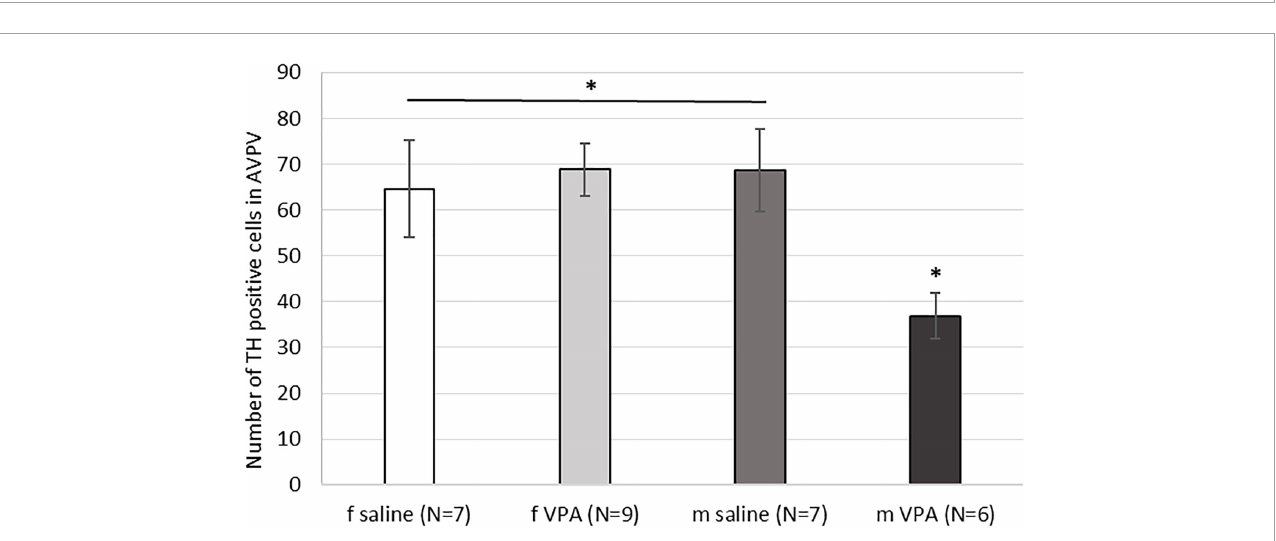
FIGURE5 Expression of tyrosine hydroxylase (TH) immunopositive cells within the anteroventral periventricular nucleus (AVPV) in control and valproate (VPA) mice. VPA males had significantly lower ( p ∗ < 0.05) number of TH immunopositive cells than saline males and females of both